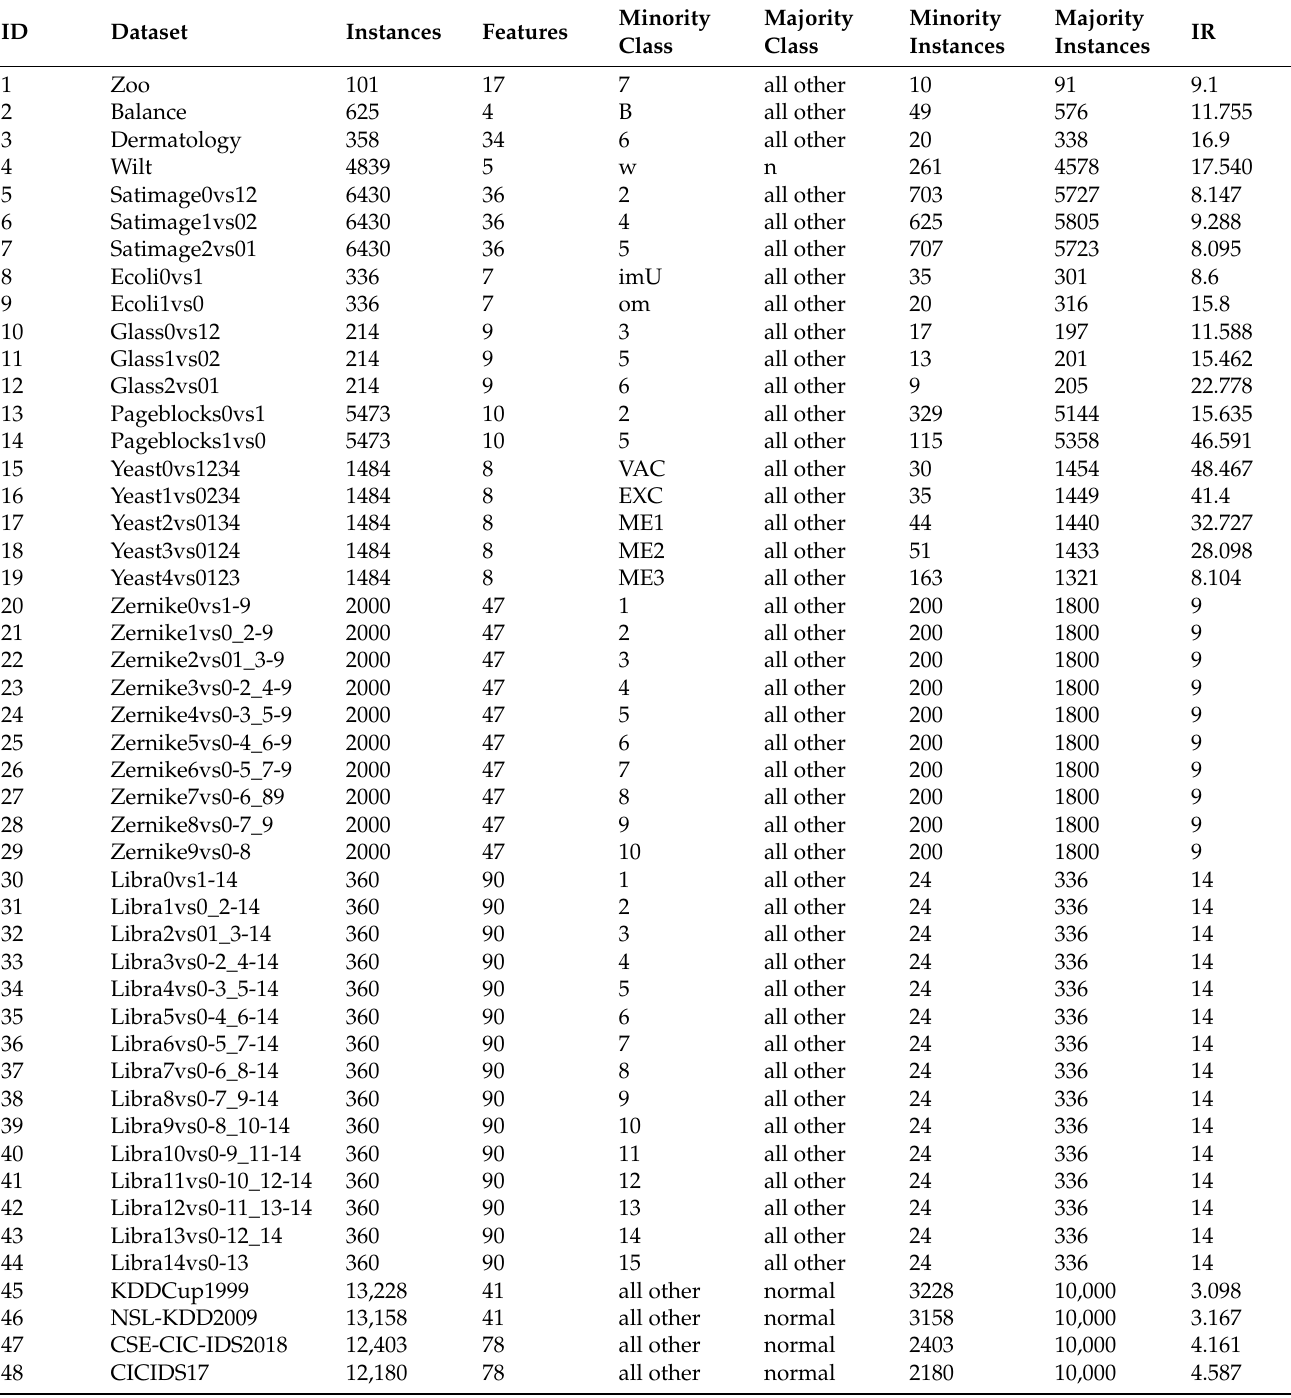
Table 2. Characteristics of the imbalanced data used in the